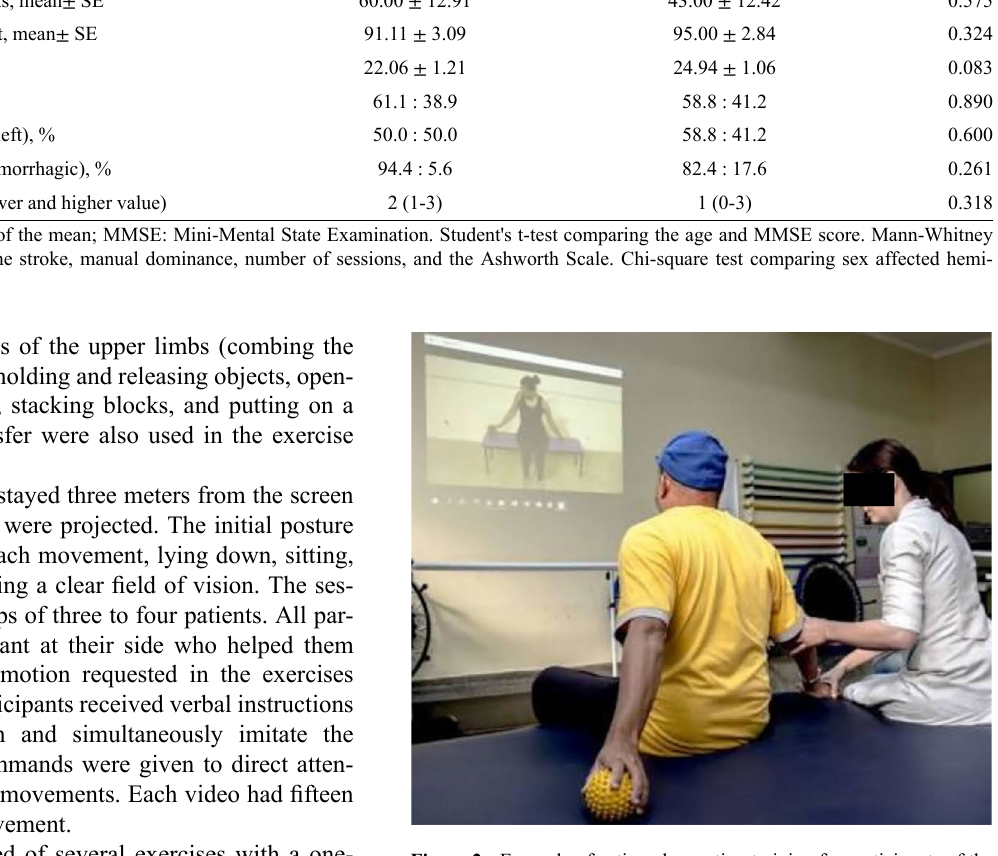
Figure 2 - Example of action observation training for participants of the